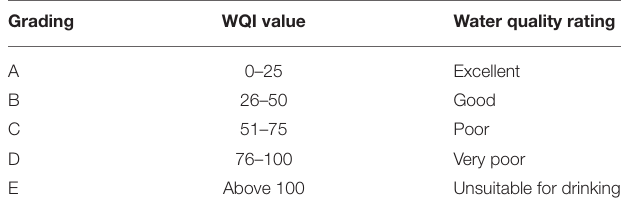
TABLE 1 | The standard values of water quality index (WQI) using weight arithmetic water quality index method.